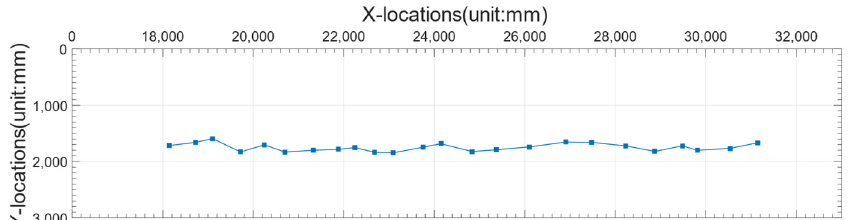
Figure 15. Detection of vehicles in field measurement.